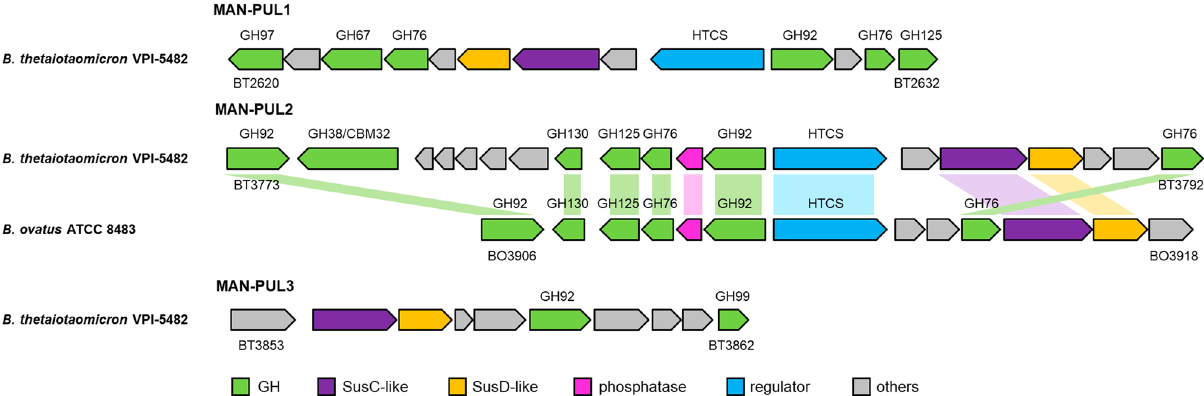
Figure 7. Bacteroides thetaiotaomicron VPI-5842 and Bacteroides ovatus ATCC 8483 yeast mannan polysaccharide utilisation loci (PULs). Each gene is depicted to reflect its orientation and scale on the genome. The number below each gene is its locus tag. Genes encoding known or predicted functionalities are colour- coded: glycoside hydrolase (GH; green), SusC-like proteins (SusC-like; purple), SusD-like proteins (SusD-like; orange), phosphatase (phosphatase; pink), regulatory proteins (regulator; blue), and other proteins (others;